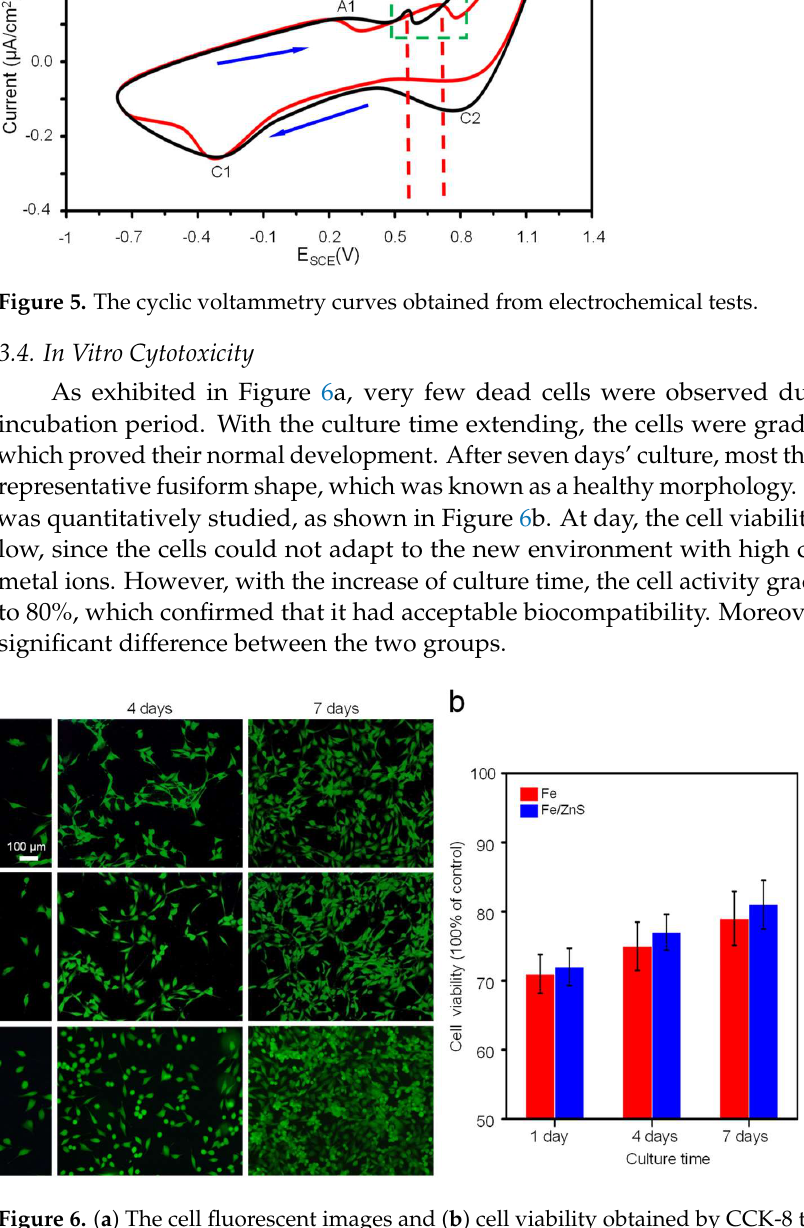
Figure 6. ( a ) The cell fluorescent images and ( b ) cell viability obtained by CCK-8 testing